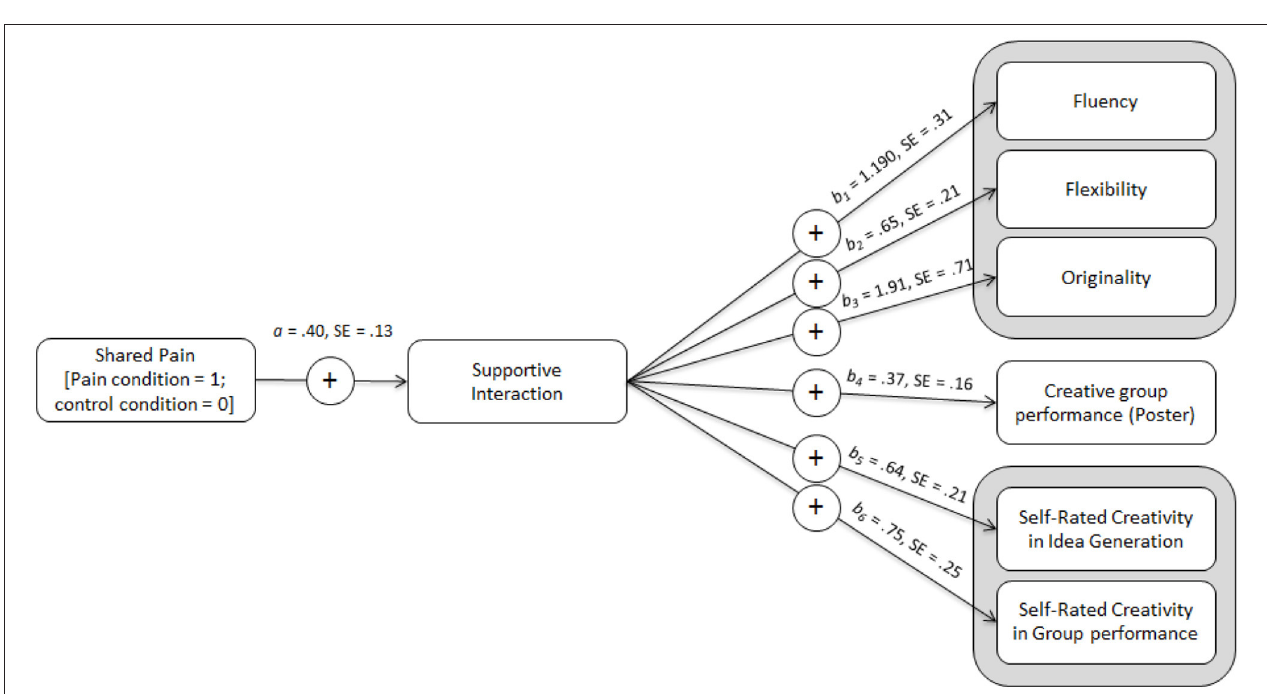
FIGURE 1 | Mediation displaying coefficients for paths from shared pain through supportive interaction to (a) creative idea generation (fluency, flexibility, and originality), (b) creative group performance in poster generation task, and (c) self-perceived creativity (in idea generation and group